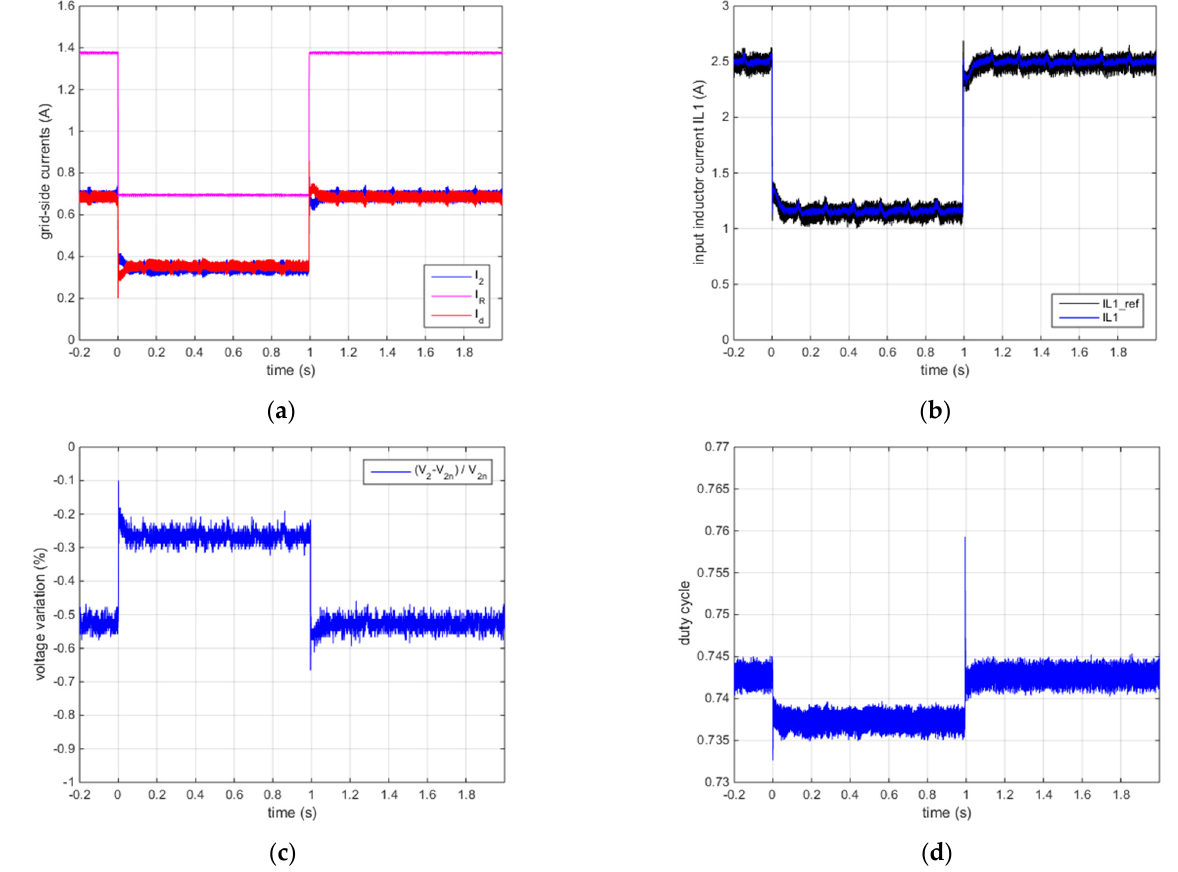
Figure 12. Experimental results in scenario #3 (SD − GD): ( a ) grid − side currents; ( b ) input inductor current; ( c ) percentage variation of microgrid voltage; ( d ) duty cycle.